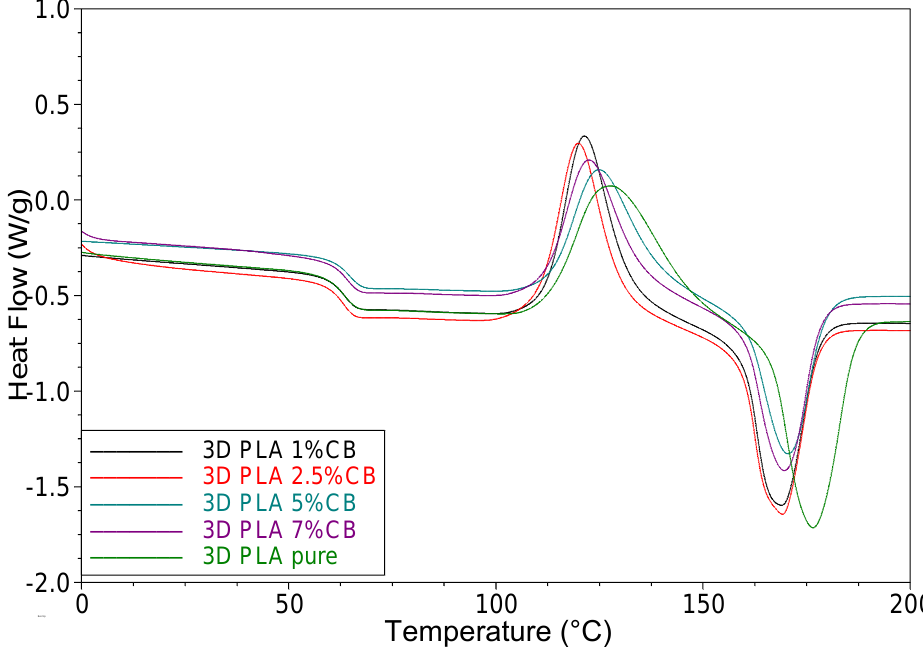
Figure 11. DSC curves ( Ⅱ run) of the 3D-printed specimens, obtained from the composite filaments with various CB content.